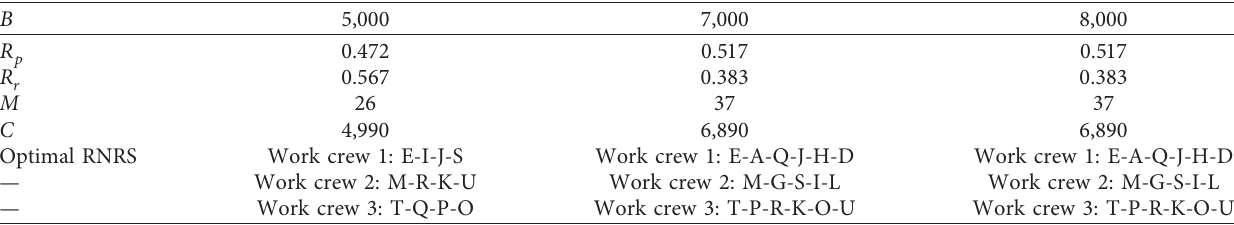
Table 7: Effect of B on the optimal RNRS.